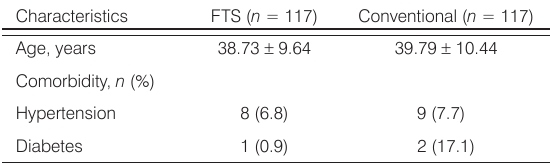
Table 1. Baseline clinical characteristics of the patients.